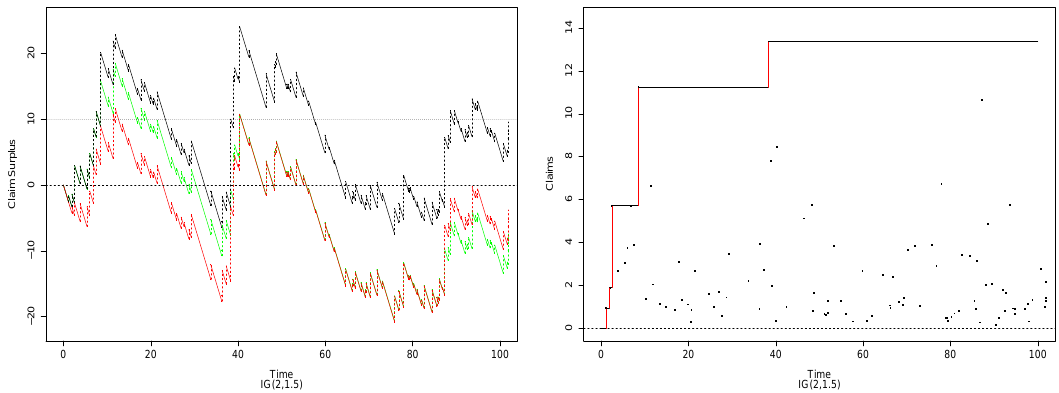
Figure 4. Sample paths of the insurance risk processes without reinsurance (black line), with LCR reinsurance (red line), and with EOL reinsurance (green line), for an IG ( 2,1.5 ) claim distribution. The safety loading is θ = 0.1, expected claim size is µ = 2, claim arrival rate is λ = 1, and each time unit is 0.01 years. L for the EOL scheme is chosen so that the expected values of the LCR and EOL claim distributions are equal at maturity time T = 5000. Table 2. LCR reinsurance for Gamma ( 2,1 ) distributed claims. The safety loading is θ = 0.1, expected claim size is µ = 2, claim arrival rate is λ = 1, and each time unit is 0.01 years. Simulations are done with N = 100,000 sample